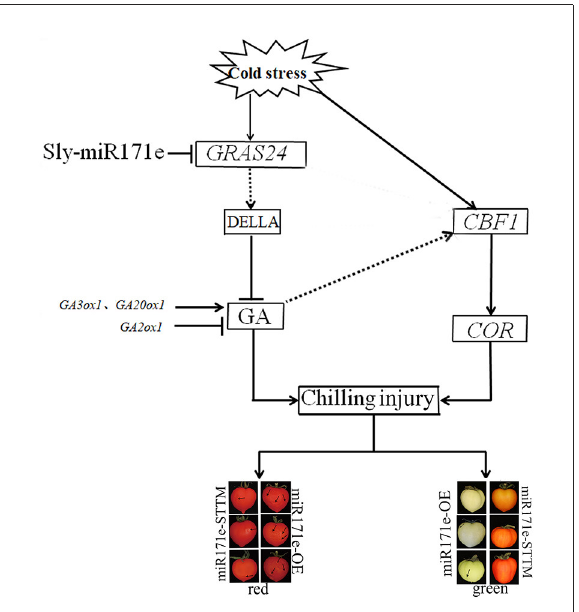
FIGURE7 Regulation mechanism of Sly-miR171e on cold tolerance in tomato fruit stored at low